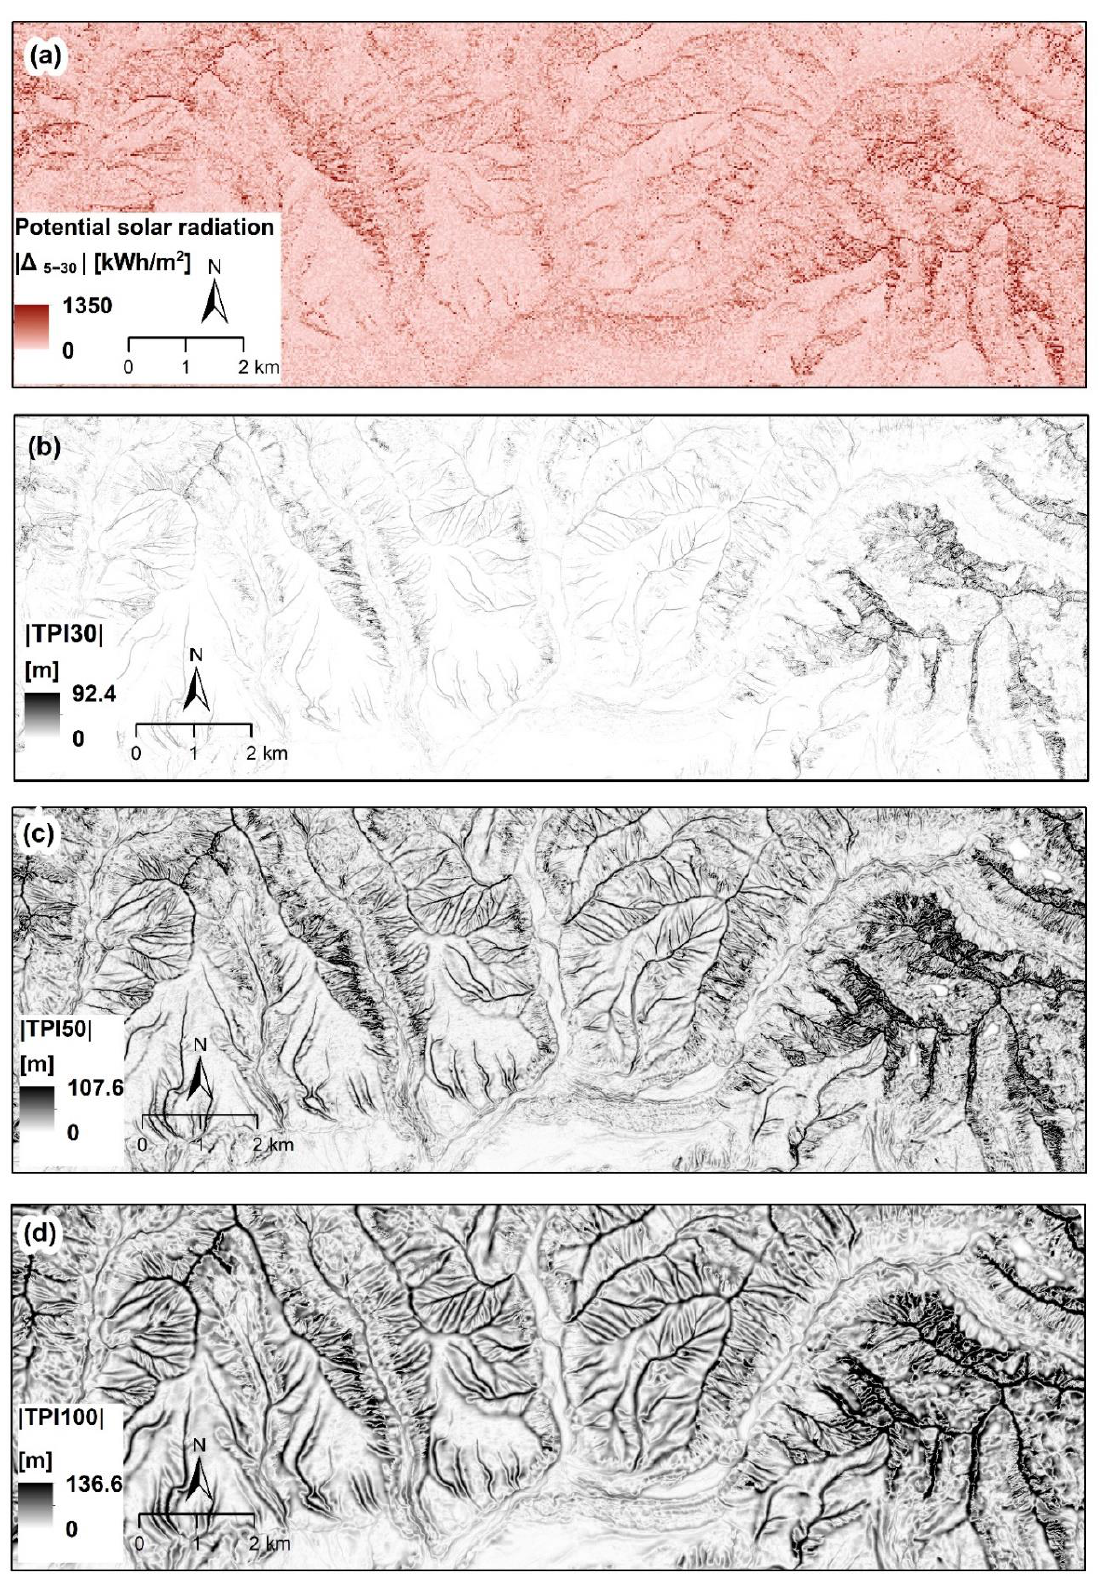
Figure 6. Absolute values of the differences between potential solar radiation calculated at a resolution of 5 m and 30 m ( a ); the absolute values of TPI calculated with a circular neighbourhood of 30 m ( b ), 50 m ( c ), and 100 m ( d ) based on DTM 5.0 at a spatial resolution of 5 m. Data source: Ú GKK SR [45].